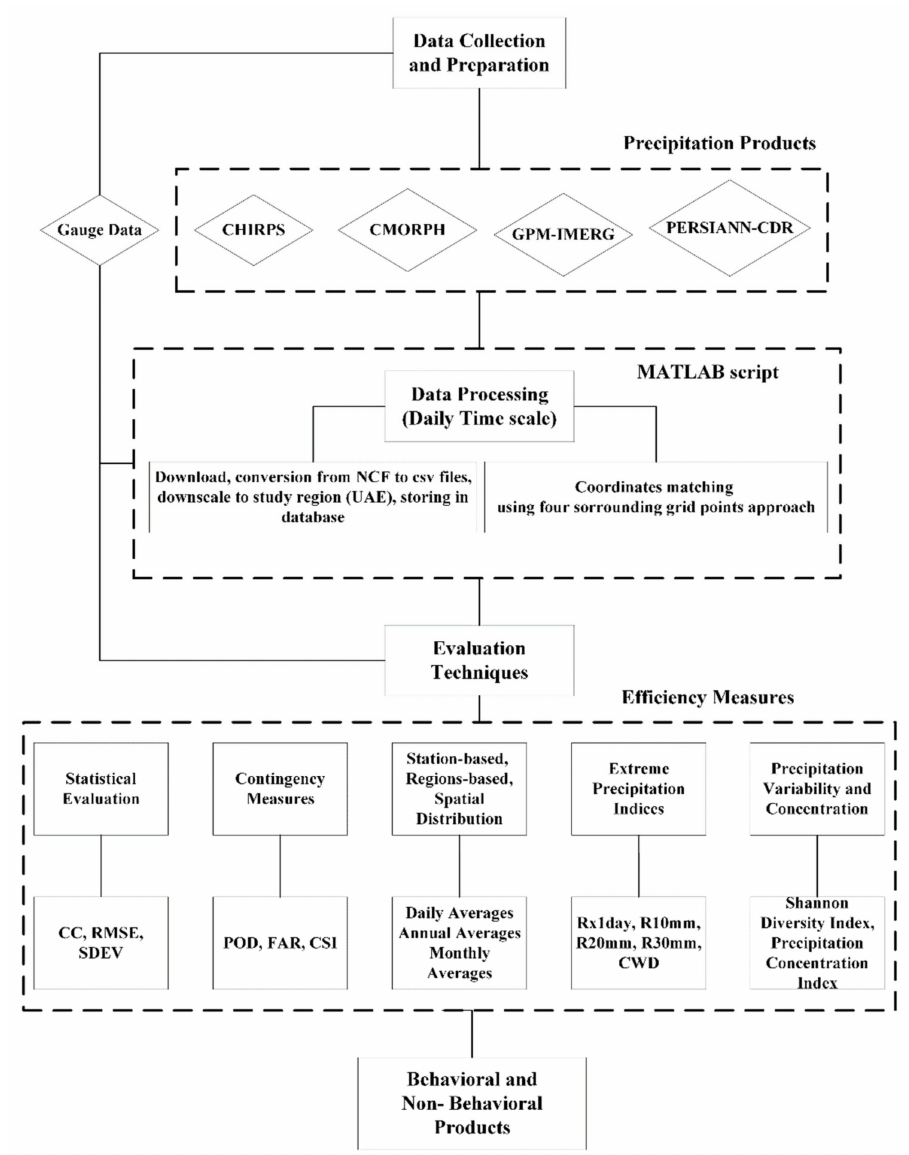
Figure 2. Flow chart of the implemented